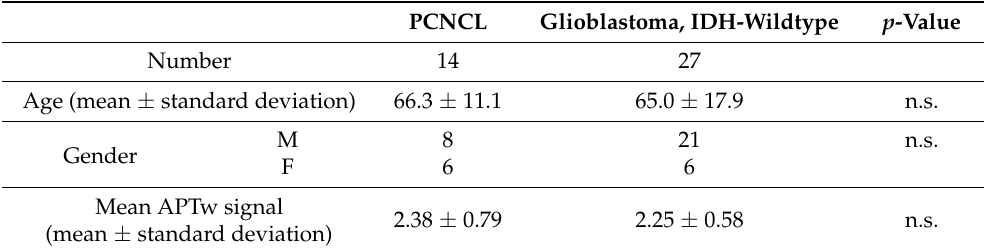
Table 1. Clinical characteristics of PCNSL and glioblastoma, IDH-wildtype. PCNCL Glioblastoma, IDH-Wildtype p -Value Number 14 27 66.3 ± 11.1